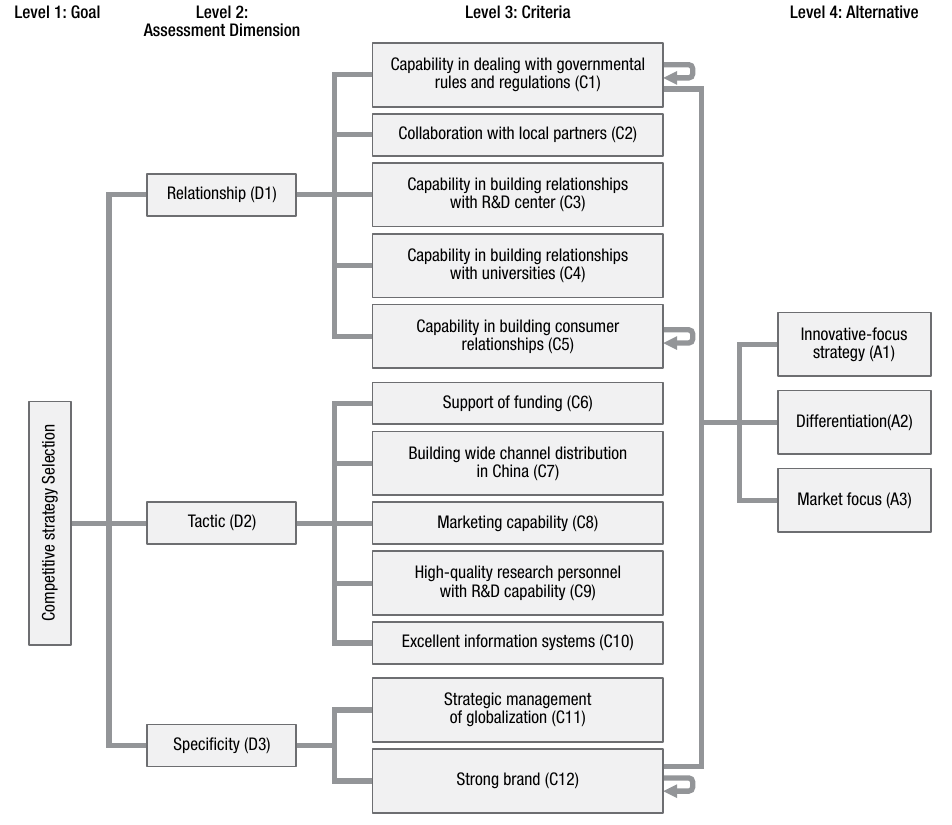
Fig. 4. A hierarchical model for business-strategy selection